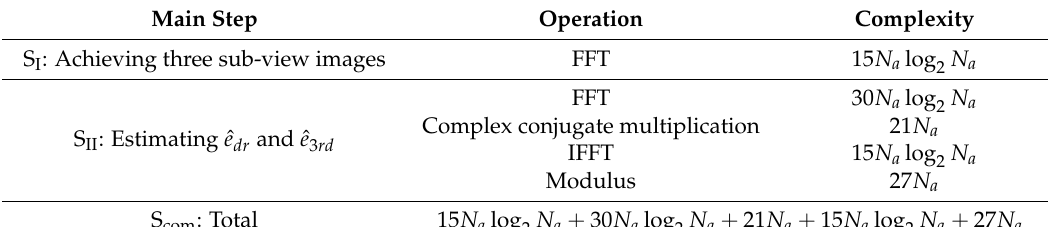
Table 2. The complexity of the main steps of the basic MAM method.